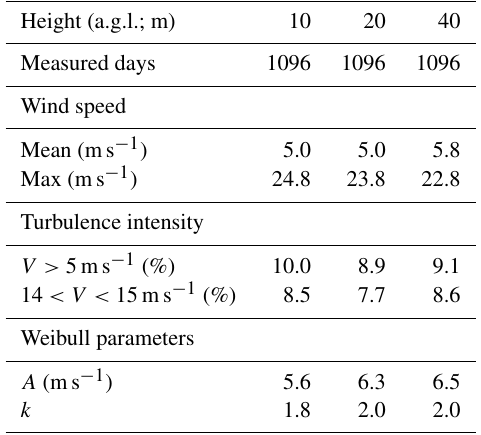
Table 2. Wind characteristics (January 2002–December